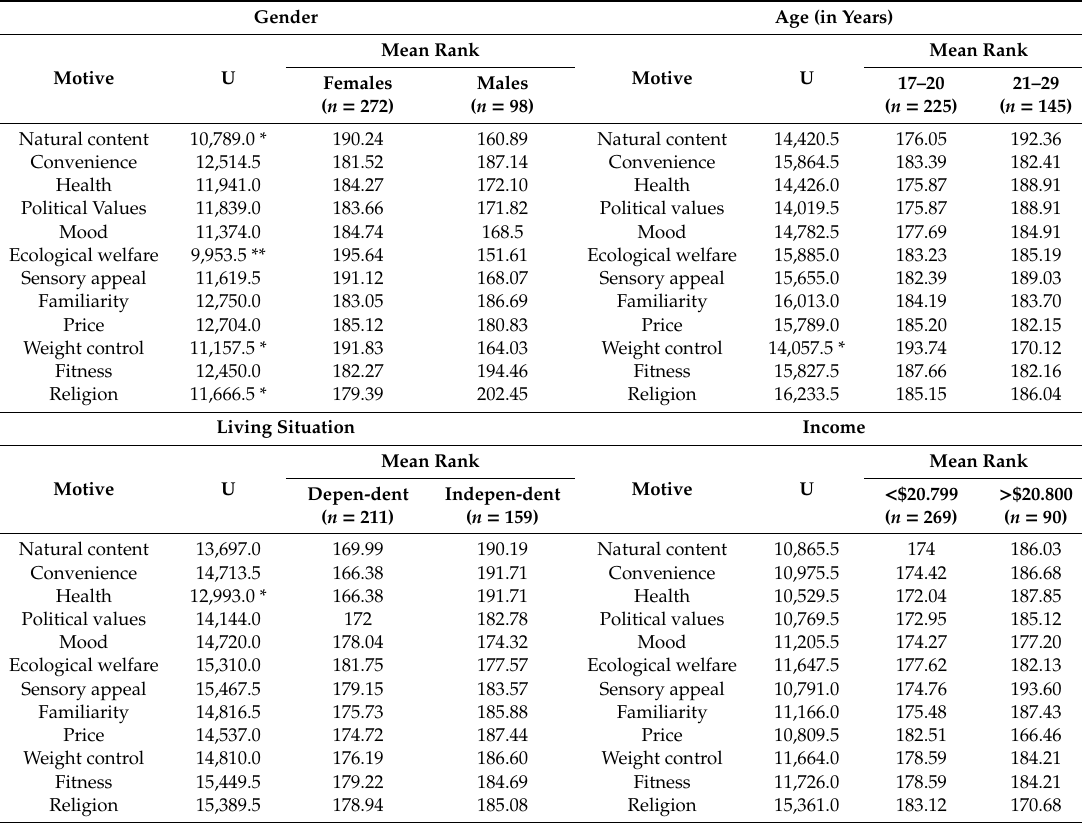
Table 3. Di ff erences in the mean rank of the FCMs by gender, age, living situation and income.